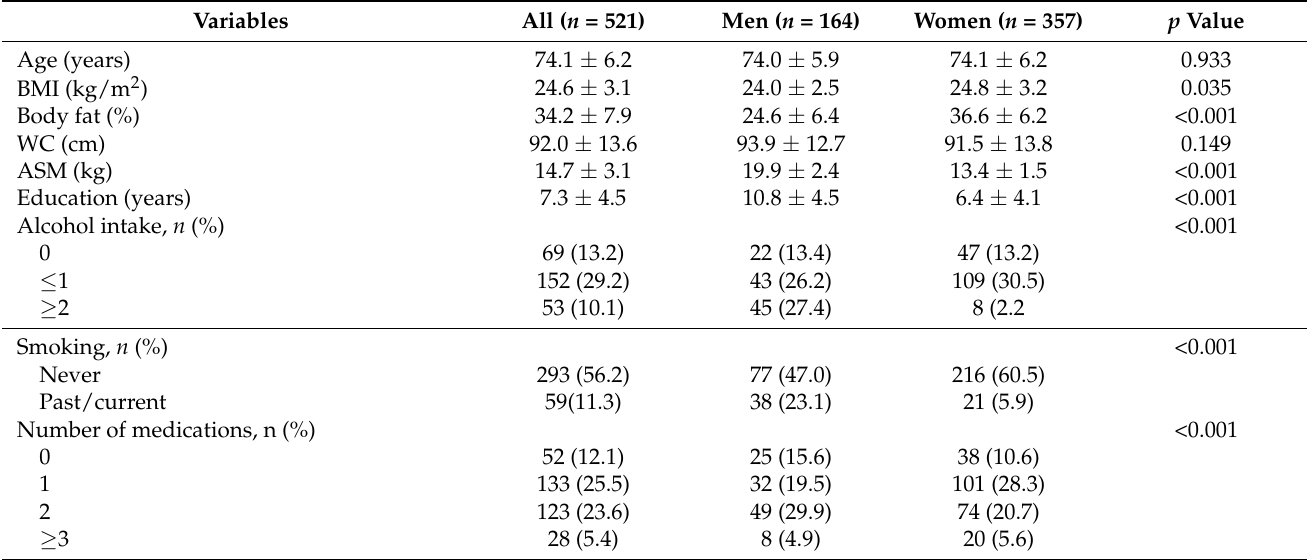
Table 1. Characteristics of study